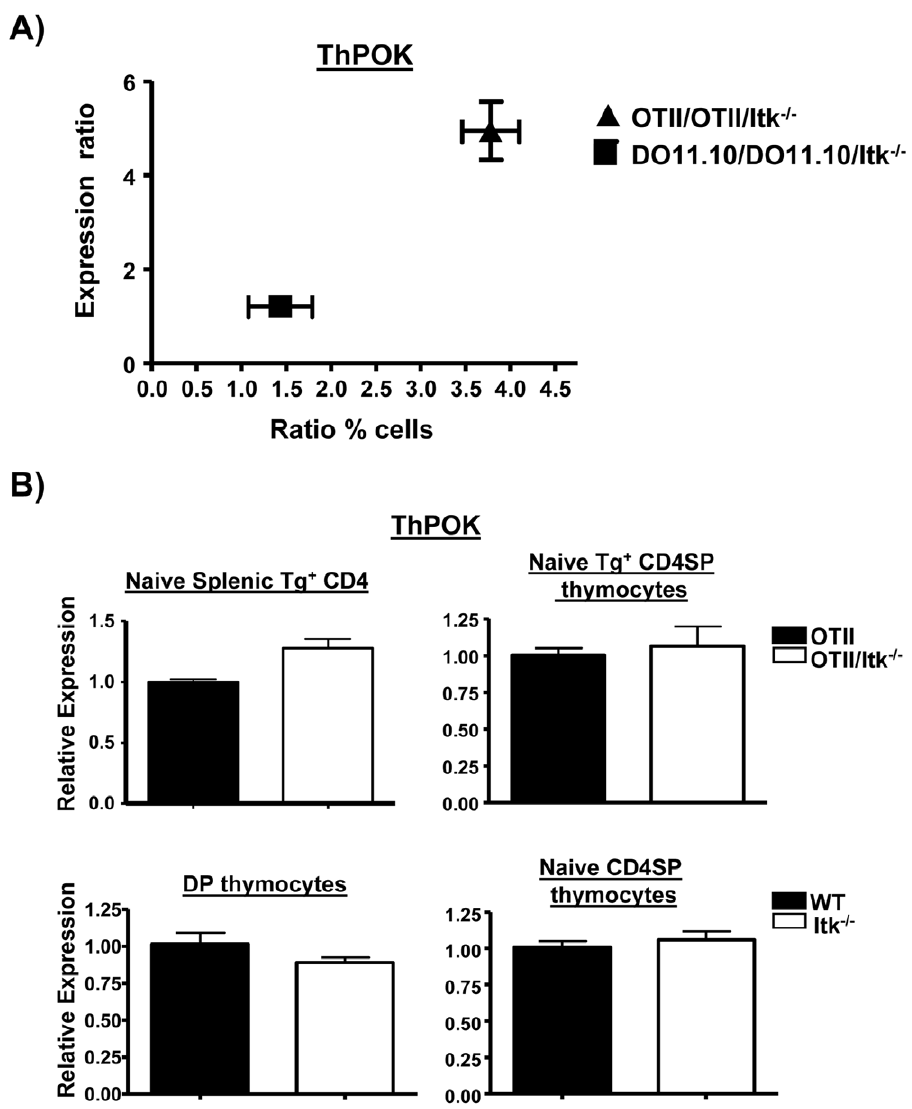
Figure 10. Itk mediated signals intersect with TCR affinity to regulate the expression of Th-POK and the development of CD4 + T cells. ( A ) The ratios and percentages of CD4SP thymocytes in OT-II:OTII/Itk 2 / 2 (triangles) and DO11.10:DO11.10/Itk 2 / 2 (squares) mice were plotted against the corresponding ratios of the expression of Th-POK in their DP thymocyte population. ( B ) Quantitative real-time RT-PCR for Th-POK in sorted transgenic TCR + naı¨ve splenic CD4 + T cells (top left), sorted transgenic TCR + naı¨ve CD4SP thymocytes (top right), sorted non-transgenic DP thymocytes (bottom left) or sorted non-transgenic naı¨ve splenic CD4 + T cells (bottom right). Data are corrected for GAPDH expression and expressed as fold over mRNA of the corresponding WT mice, which was set at 1 (n=3 with no significant difference